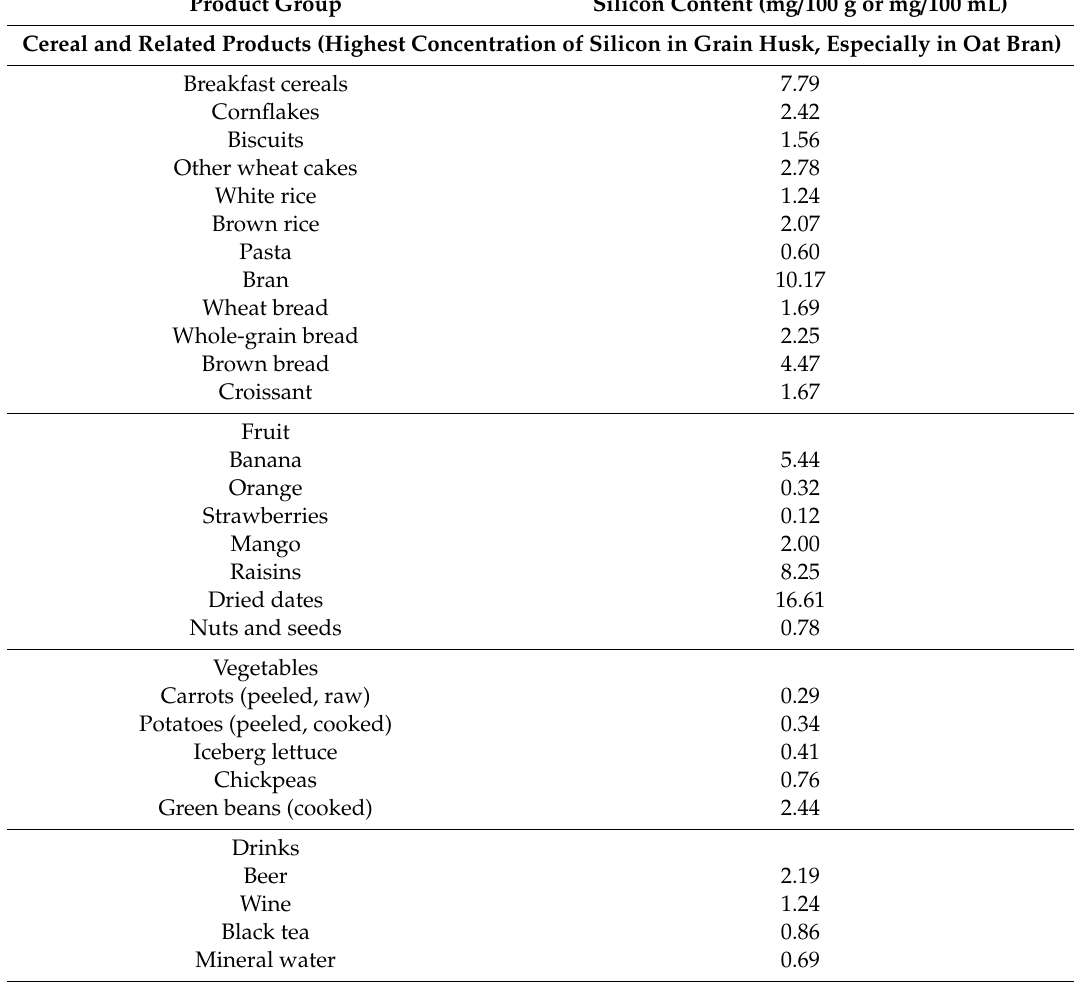
Table 1. Silicon content in food products